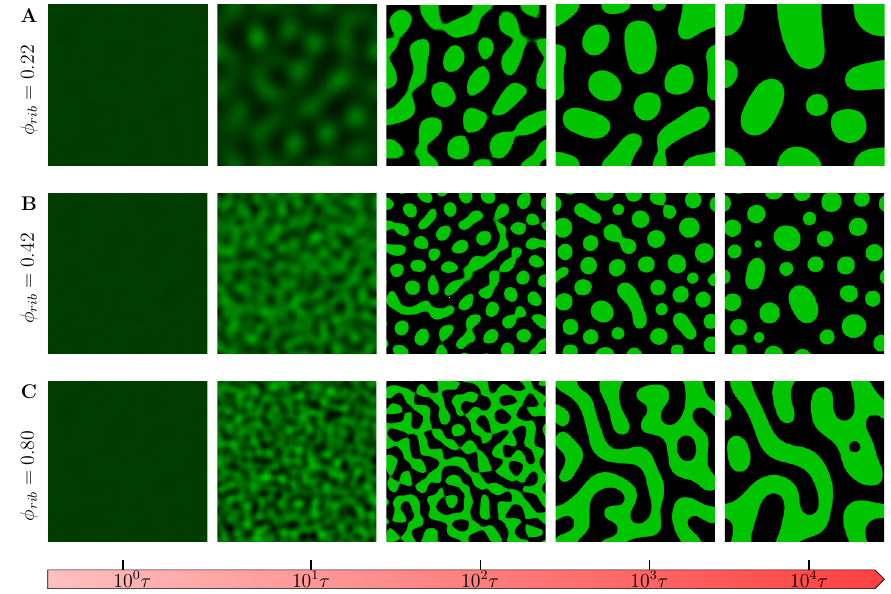
Figure 5. Evolution of the phase-separated morphology of the field variable φ ( r , t ) with the chemical ( φ ) = 0 for selected crowder concentrations. ( A ) At very low crowder concentrations reaction rate R φ rib = 0.22, the late-stage (10 4 τ ) coarsened morphology is on average round droplets, as usually observed in in vitro experiments; ( B ) an increase in crowder concentration φ rib = 0.42 results in smaller droplets being coarsened at late stage of the evolution of the field φ ( r , t ) ; and ( C ) any further increase in the crowder concentration results in the morphologies taking labyrinthine patterns with a smaller characteristic wavelength reminiscent of arrested gel-like phases (see Supplementary Materials Video S1 and S2.). Refer also to [73] where similar observations have been recently experimentally verified in peptide/oligonucleotide